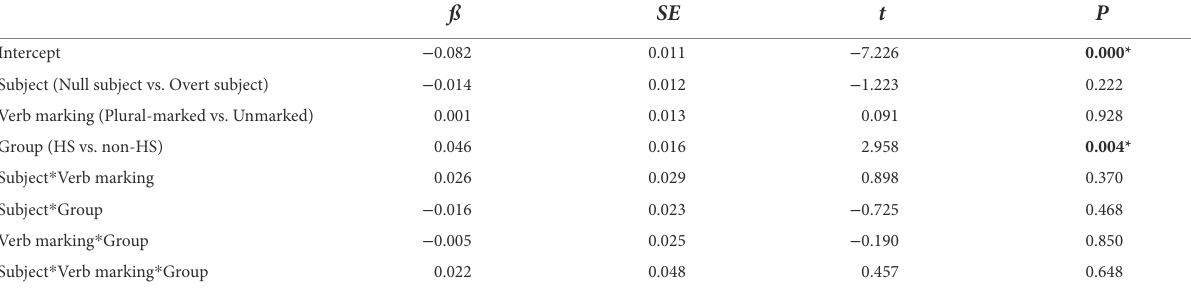
TABLE 2 Linear mixed effects model output for Region 3 (Before the